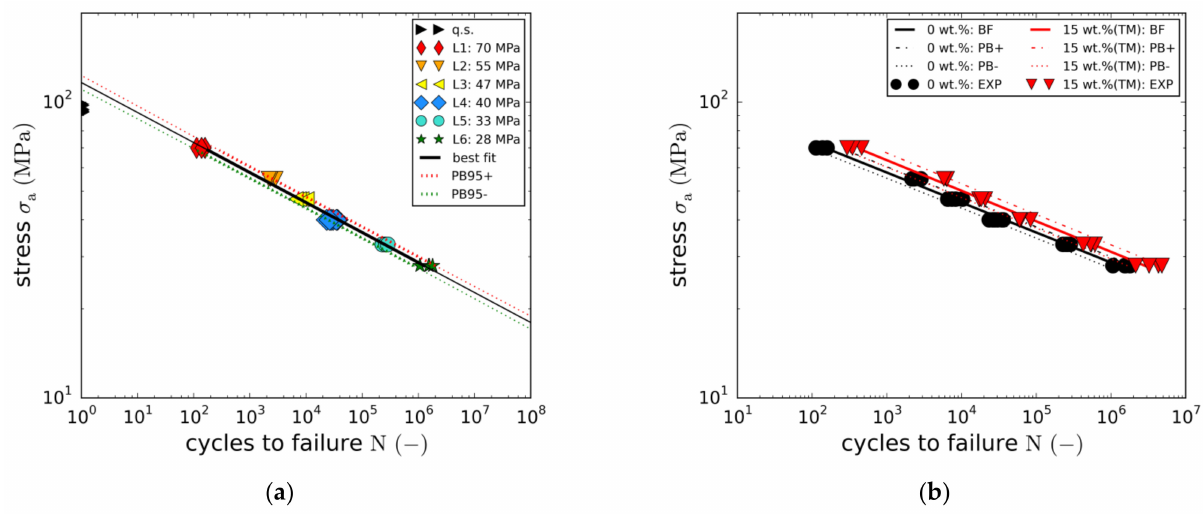
Figure 7. ( a ) S-N-curve of the reference material; ( b ) S-N-curves of reference GFRP and with 15 wt.% (TM) taurine-modified boehmite